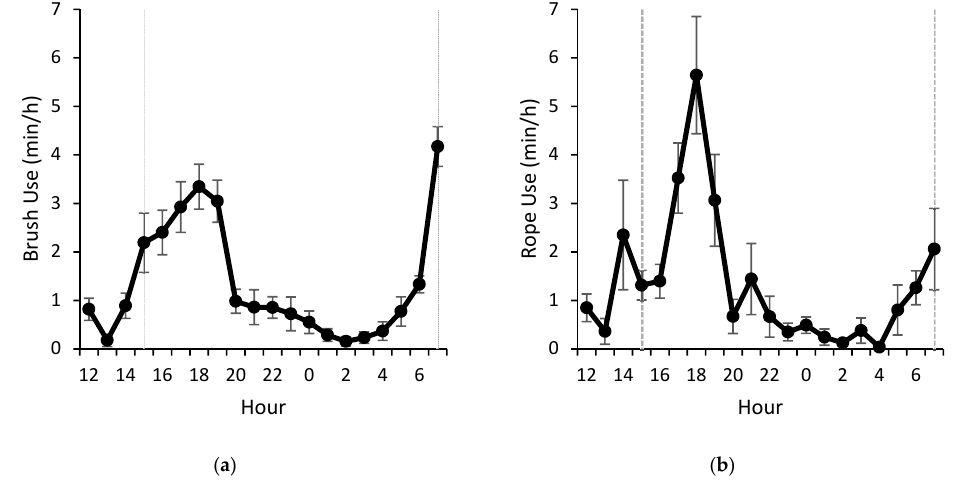
Figure 2. Mean (±SEM) time spent using ( a ) brush and ( b ) rope for 7 calves averaged for 3 days (d1, d3, and d6). Observations spanned from 12:00 to 08:00 the following day. Calves were fed 4 L of whole milk from a 5-nipple milk feeder twice daily at 07:00 and 15:00 (dotted line); feeders were left in the pen for 30 min to ensure the full milk meal was consumed.